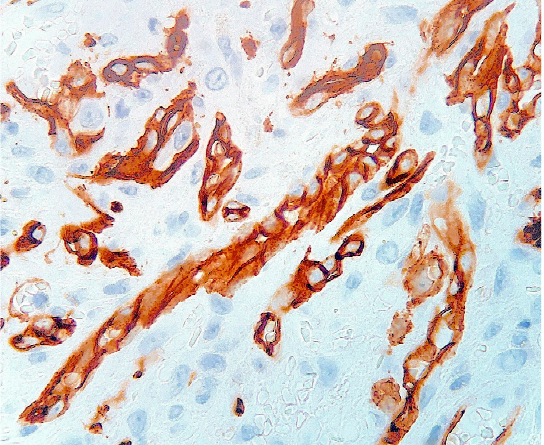
Figure 7. The tumour cells express CD34 (immunoperoxidase revealed with diaminobenzidine).